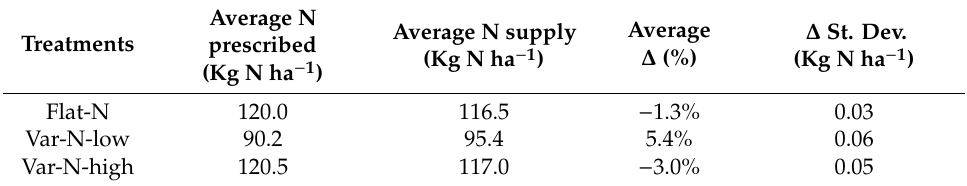
Figure 4. ( a ) Comparison between prescription map and the distributed Sulky output. ( b ) Scatter plot 215 between the prescribed and distributed rate within each plot. 216 Table 1. Amounts of N prescribed and supplied with the second N application in the three treatments: 217 Flat-N (standard rate of 120 kg N ha − 1 ), Var-N-low (variable rate from 60 to 120 kg N ha − 1 ), Var-N-high 218 (variable rate from 90 to 150 kg N ha − 1 ). 219